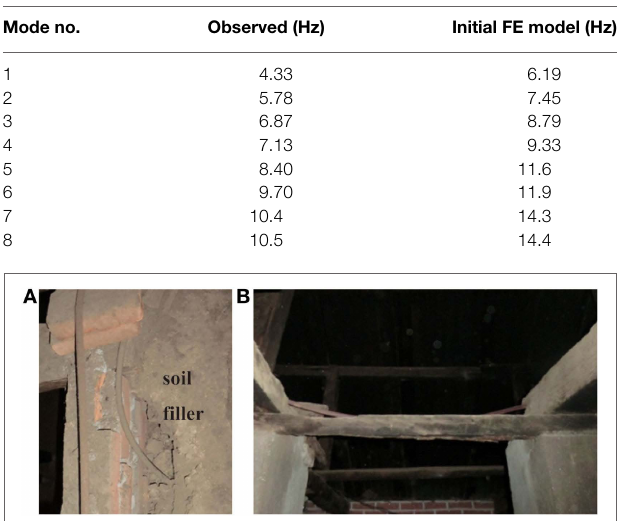
TABLE 4 | Initial finite element model for the building before the earthquake: comparison of observed natural frequencies with the analytical natural frequencies of the initial finite element model for the building before earthquake.